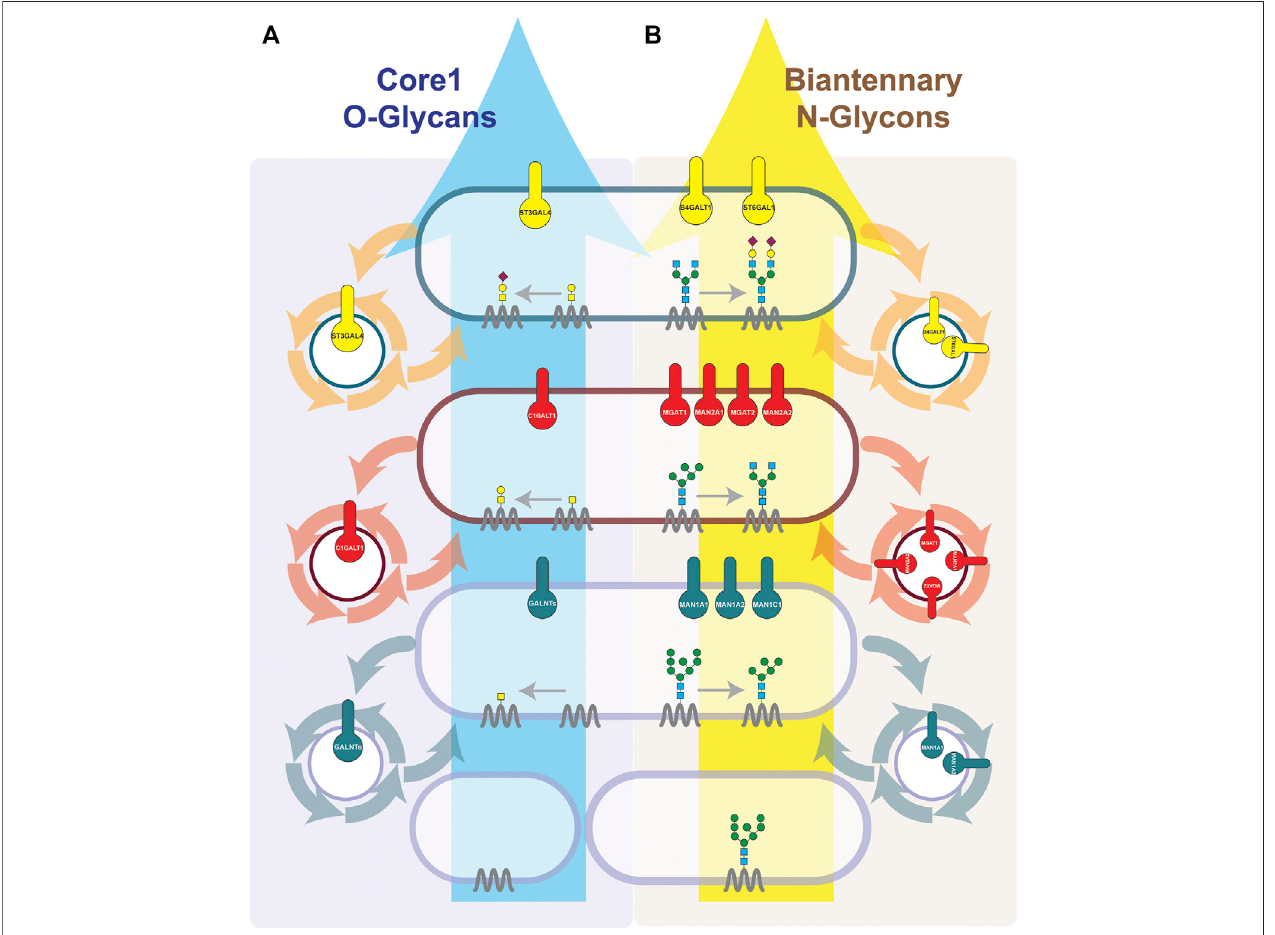
FIGURE 1 | Cisternal maturation controls the positioning of different subsets of glycoenzymes within each Golgi cisterna. The synthesis of Core-1 O-glycans (A) and Biantennary N-glycans (B) isdepicted.We represent how the cisternal maturation machineries (COPI-dependent or COPI-independent) bycontrolling therecycling of each serial acting enzymes regulate their localization in the cis -, medial- or trans -Golgi and de fi ne the fi nal glycosylation outcome. Sequentially acting enzymes are known to interact with each other and form an enzymatic module within the same cisterna (Khoder-Agha et al., 2019). Enzymes are known to be enriched in 1 – 2 cisterna, with some enzymes having a sharper localization then others (Tie et al., 2018; Pothukuchi et al., 2021). We have represented them in single cisterna for communication purposes. Brie fl y, O-glycosylation occurs solely at Golgi. O-linked glycosylation starts at cis- Golgi by adding GalNAc to Ser/Thr residues of a cargo protein.Then,inthemedial,basedontheavailabilityofglycosyltransferases,galactoseorGlcNAcareadded,andinthecaseofcore-1O-glycan,thegalactoseisadded. Finally, sialic acid is added by sialyltransferase present at the trans- Golgi. Unlike O-glycosylation, N-glycan biosynthesis starts at ER. Indeed, the cargos which arrive at theGolgihavealreadyundergonetheadditionofablockof14sugars,fromwhichfourglycanshavebeentrimmed.Inthe cis- Golgi,furtherthreemannosesareremoved by alpha-mannosidases as MAN1A1, MAN1A2 and MAN1C1. Then in medial-Golgi, upon the trimming of two more mannose residues by MAN2s, GlcNAc is added by MGAT1 and MGAT2, and fi nally when cargo reaches the trans- Golgi, galactosylation and fi nal sialylation cap are added.